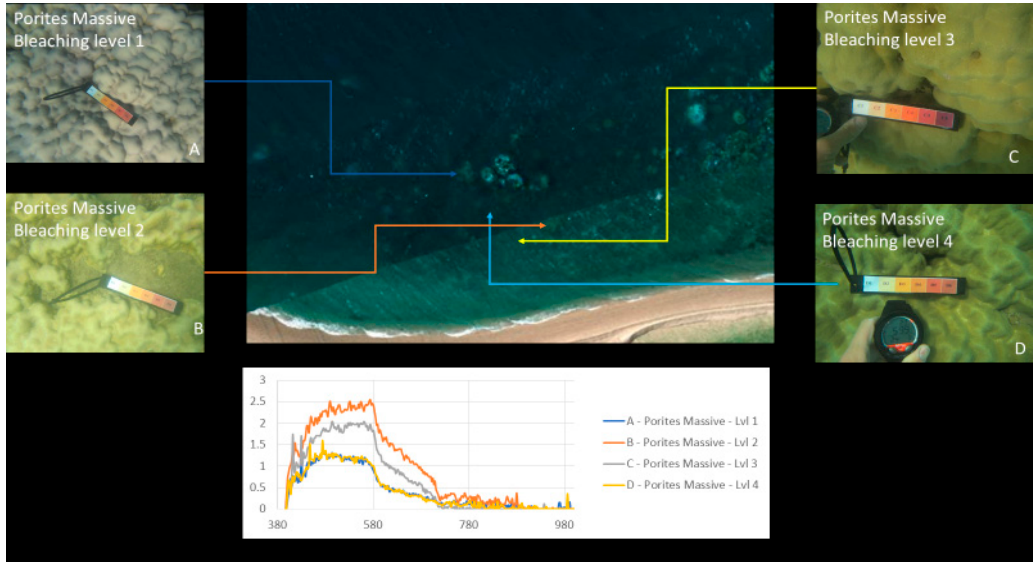
Figure 17. Example of spectral response “fingerprints” of bleaching levels 1 to 4 for Porites massive coral.